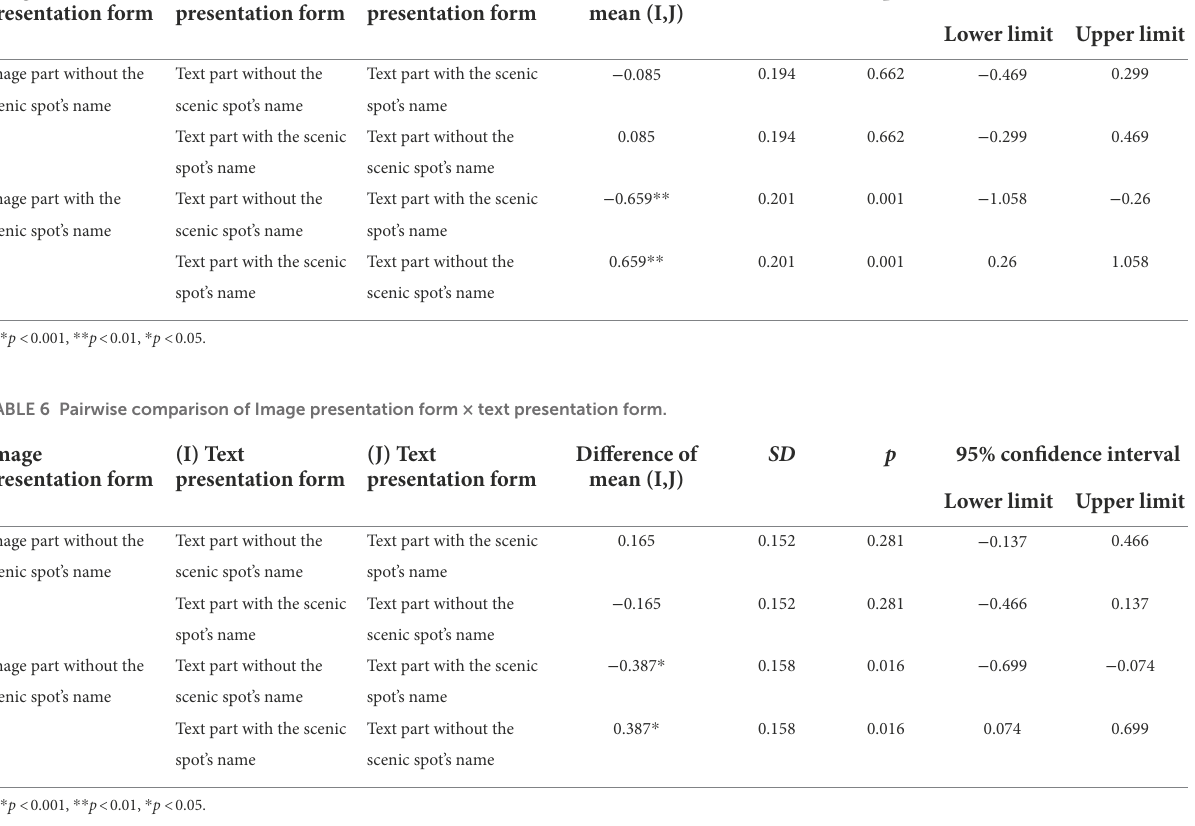
TABLE 5 Pairwise comparison of image presentation form× text presentation form. Image (I) Text (J) Text presentation form presentation form presentation